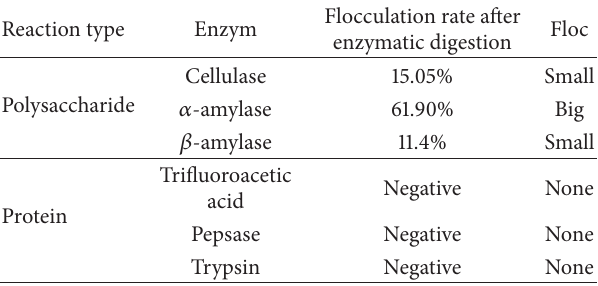
Table 3: Enzymatic digestion of flocculent active